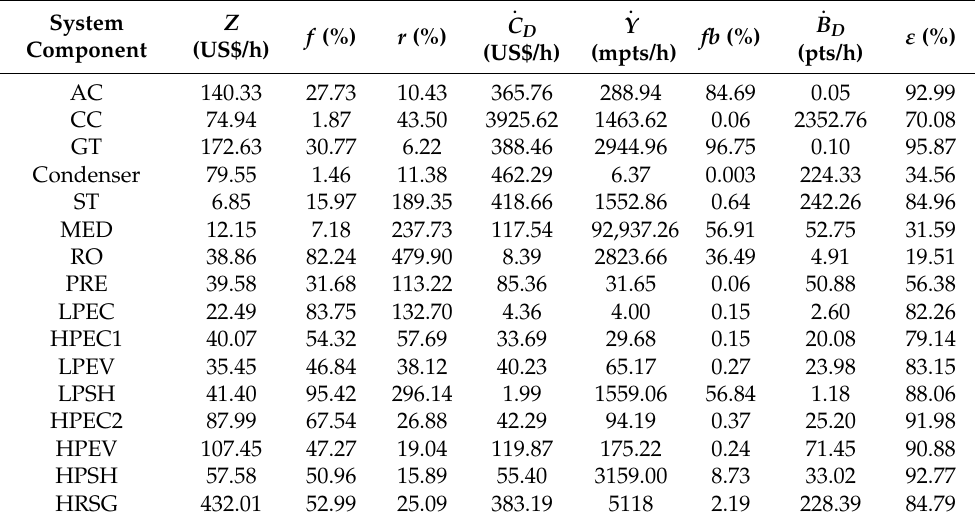
Table 9. Conventional exergy, economic, and environmental results for different system